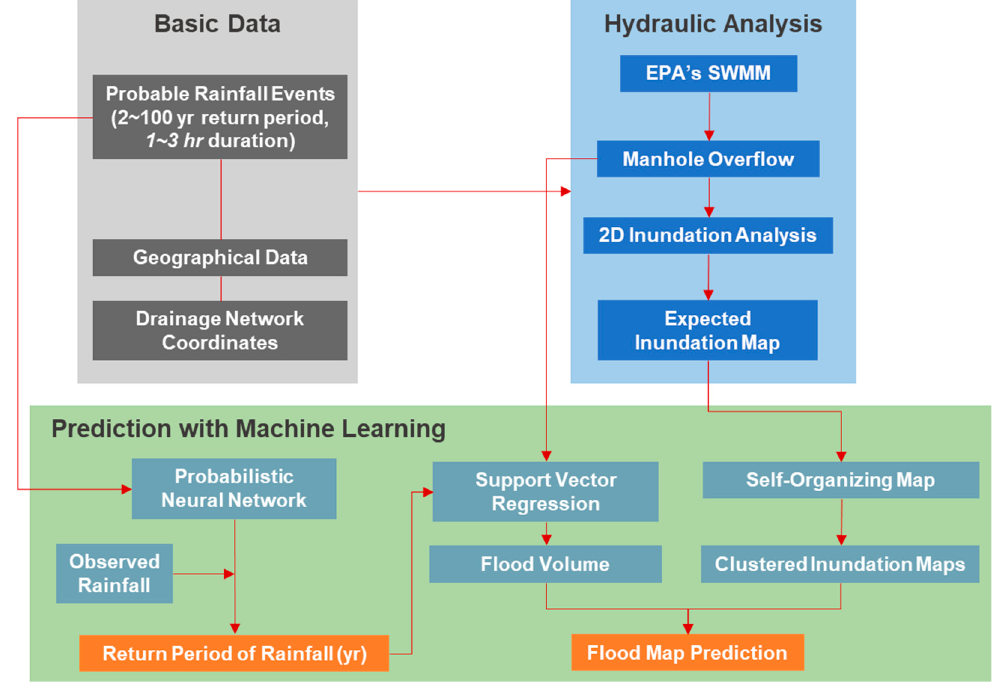
Figure 4. Study flowchart.